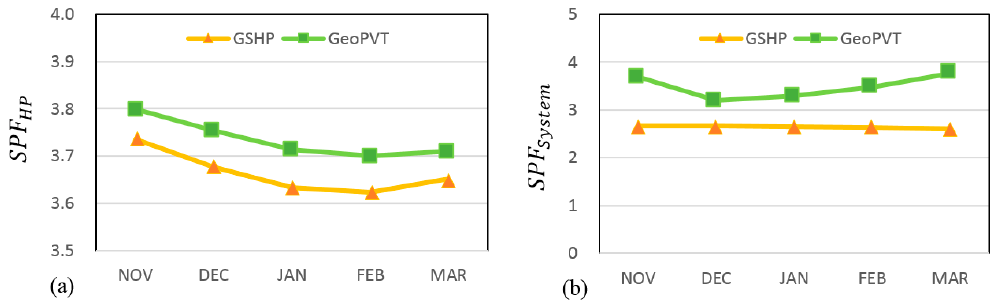
Figure 22. The result of SPF during night time operation in heating season. ( a ) Heat pump; ( b ) system.